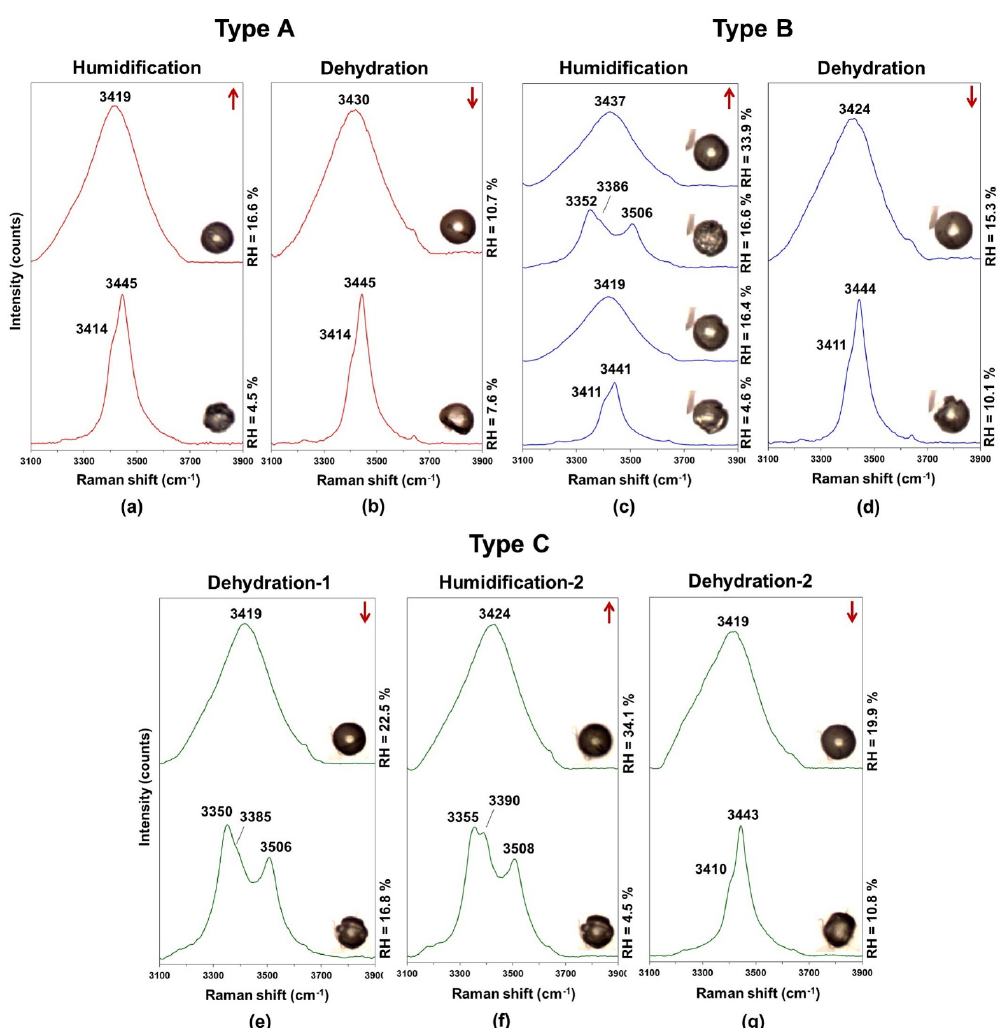
Figure 6. Characteristic OH-stretching Raman spectra and corresponding optical images of NaCl–MgCl 2 mixture particles with a composi- tion of X NaCl = 0.2, recorded by in situ RMS. Three types of particles showing different hygroscopic behavior are shown. See the text for a detailed